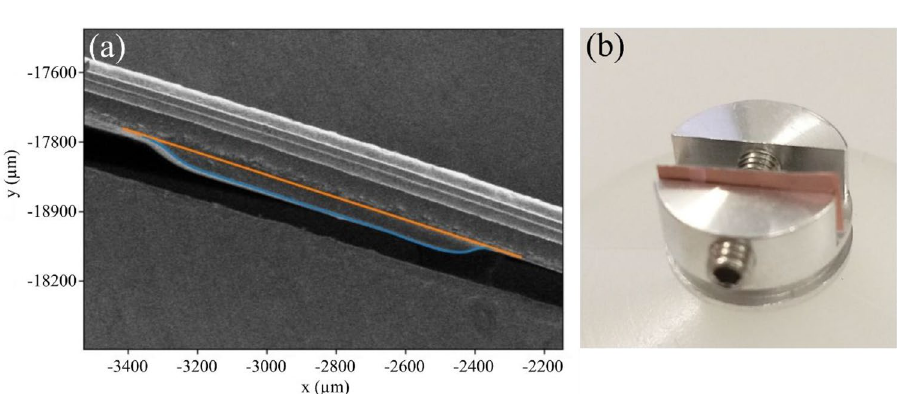
Figure 6. a shows a cross-sectional SEM image of a PDLC film on copper. The traces of the PDLC cross-section outline were made by grey-level thresholding the PDLC surface (blue line) and plotting a straight line along the copper backing interface (orange line). ( b ) shows the test sample in a cross-section holder for the SEM